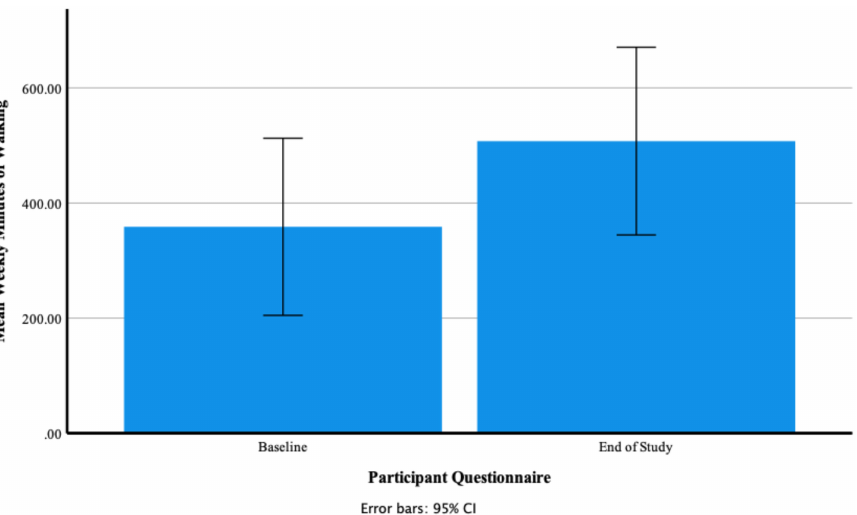
Figure 14. Participants’ self-reported mean weekly minutes of walking at baseline and end of study.